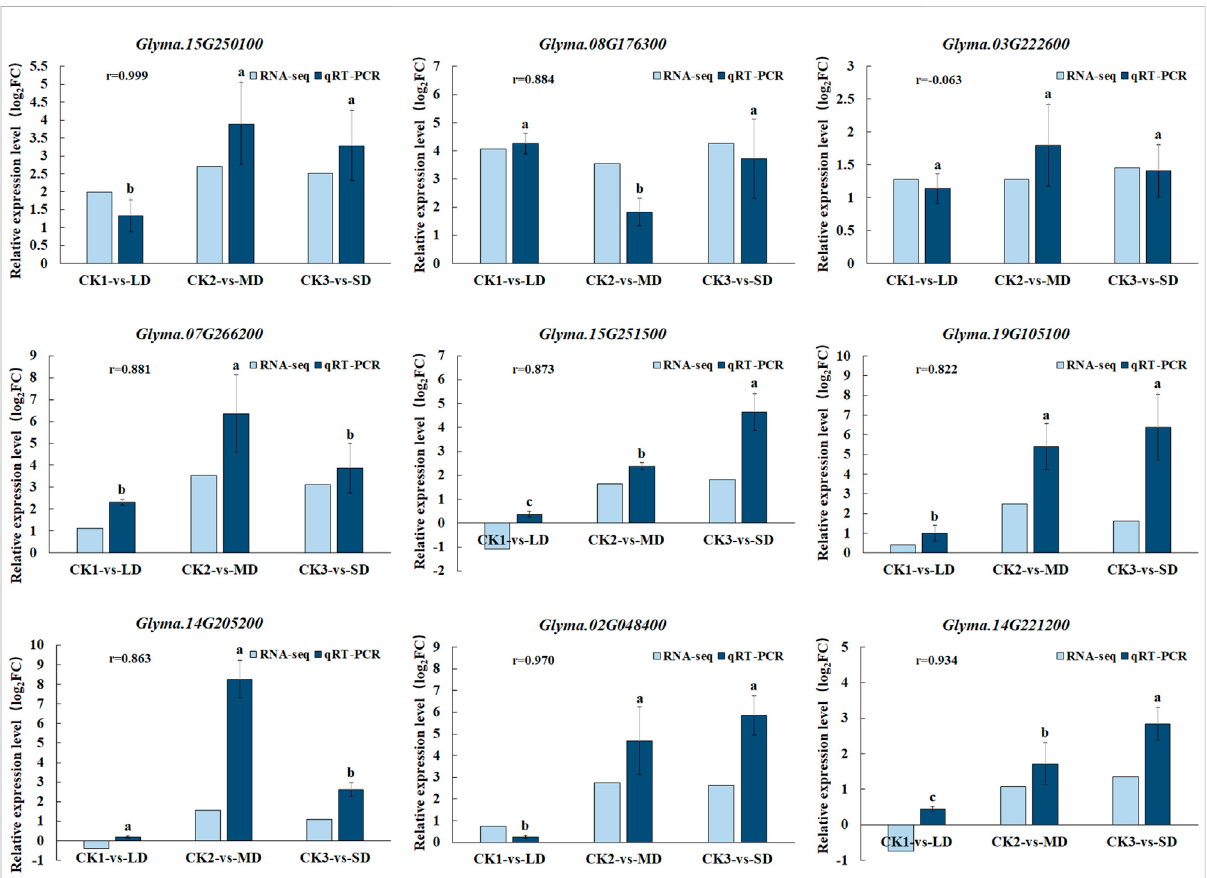
FIGURE 8 Comparison of gene expression patterns between RNA-seq and qRT-PCR under drought treatments. Data represent the means ± SD of three biological replicates, and each biological replicate contained three technical replicates ( p < 0.05).